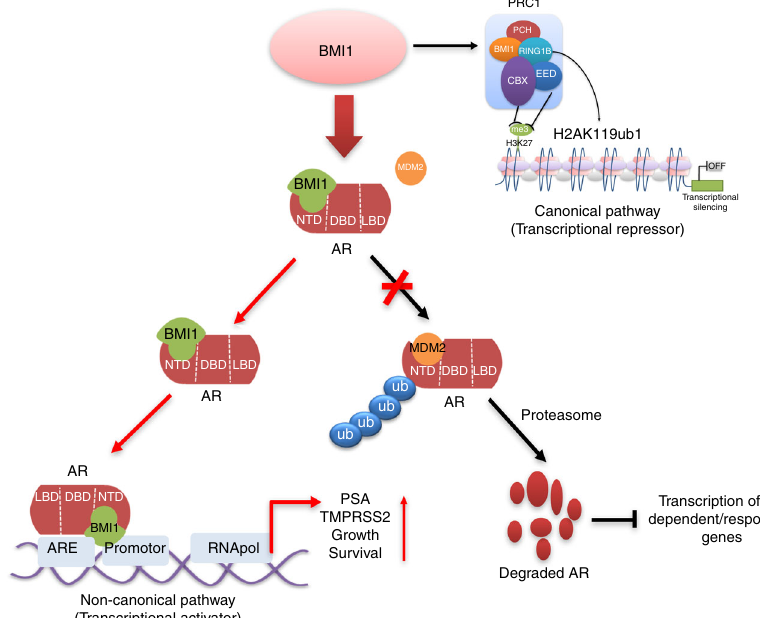
Fig. 7 Model for the regulation of BMI1 on androgen receptor independently of PRC1. Besides its PRC1-dependent role (canonical pathway) as a transcriptional repressor, BMI1 also has a PRC1-independent role (noncanonical pathway) as a transcriptional activator: BMI1 stabilizes AR and activates AR-signaling pathway via competitively inhibiting MDM2-induced ubiquitination and degradation of AR in